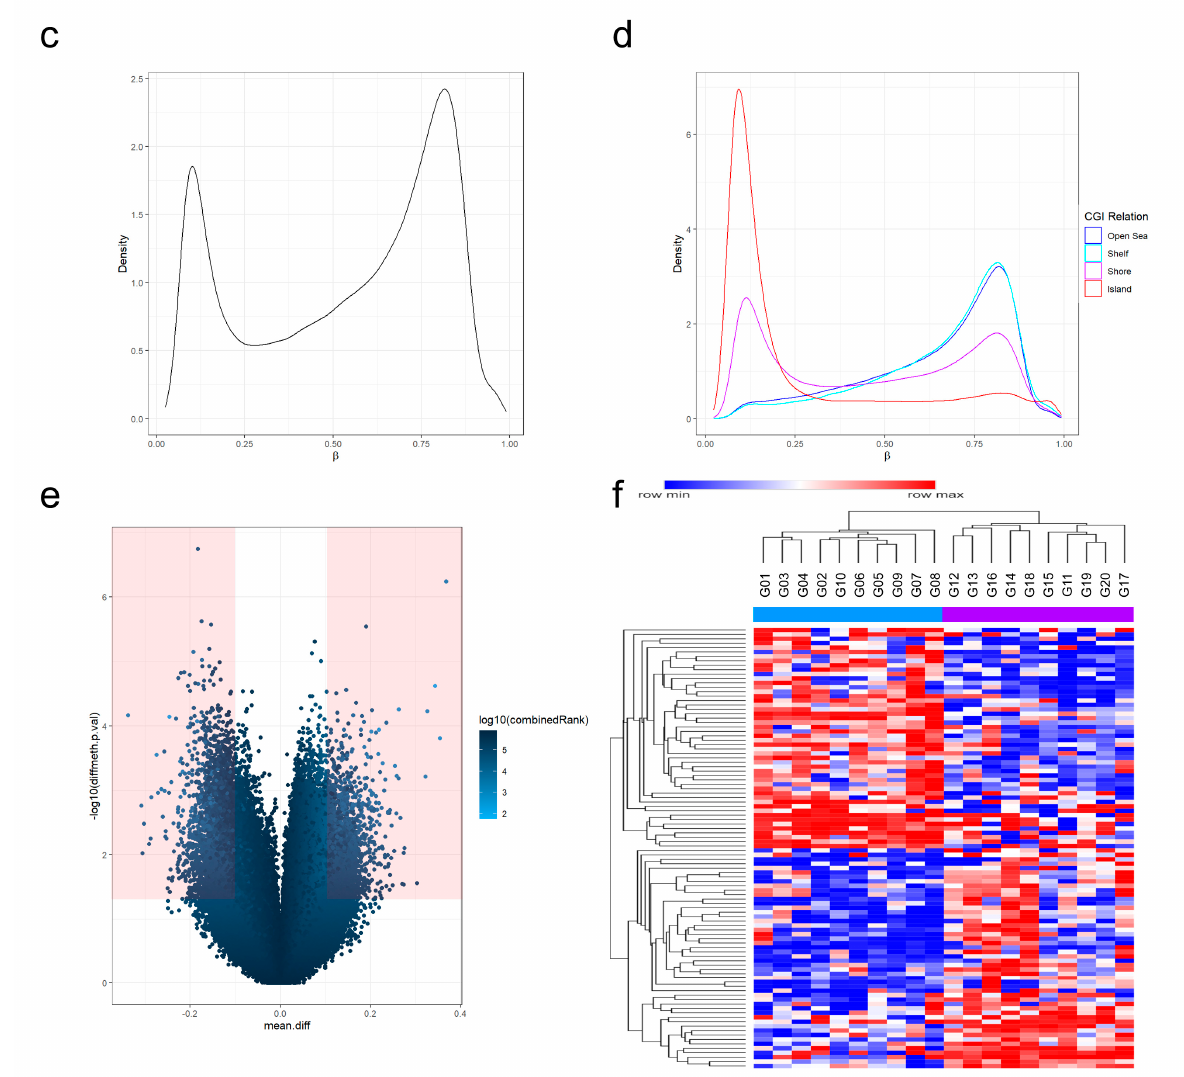
Figure 2. Exploratory methylation analysis. After probe removal and filtering, exploratory methylation analysis was performed on 820,848 probes ( a ). These retained probes were annotated with genomic region tiling, genes, promoters, and CpG islands ( b ). Analysis of global methylation distribution showed uneven distribution ( c ). Analysis of probe categories showed high densities of unmethylated values in CpG islands while high densities of methylated values were found in open sea regions ( d ). Volcano plot shows pairwise methylation analysis resulting in 12,597 significantly differentially methylated probes with ∆ β values of ≥ 0.1 and p -values of <0.05 that are indicated in red ( e ). Considering the 100 most variable CpGs, we were able to dissect the glioblastomas with high and low PD-L1 expression ( f